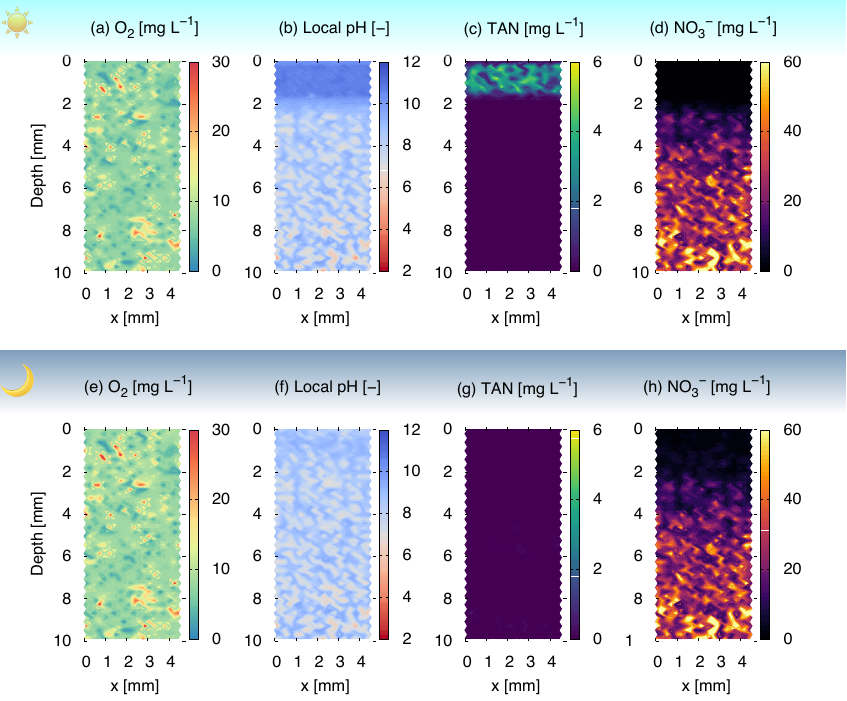
Figure 5. Diurnal distributions of chemical constituents in the desert biocrust. A typical result of simulated chemical profile within biocrusts at midday (top panel) and at midnight (bottom panel) at field capacity (wet but unsaturated). (a, e) The profile of dissolved oxygen is relatively stable during the day and night cycle. This implies that gas transport from the atmosphere is fast enough to override the consumption and production of the microbial community. (b, f) The profile of pH changes in contrast to that of oxygen. During the day, the top of the crust (within 2mm) exhibits strong alkalisation, marked as blue in the figure. During the night, pH at the top goes back to a similar level below 2mm. (c, g) Total ammonia nitrogen (TAN) increases during the day on the top of the crust due to microbial production (N 2 fixation) and decreases during the night through microbial consumption. (d, h) Nitrate distribution shows a tendency of cumulation below 4–5mm without clear diurnal